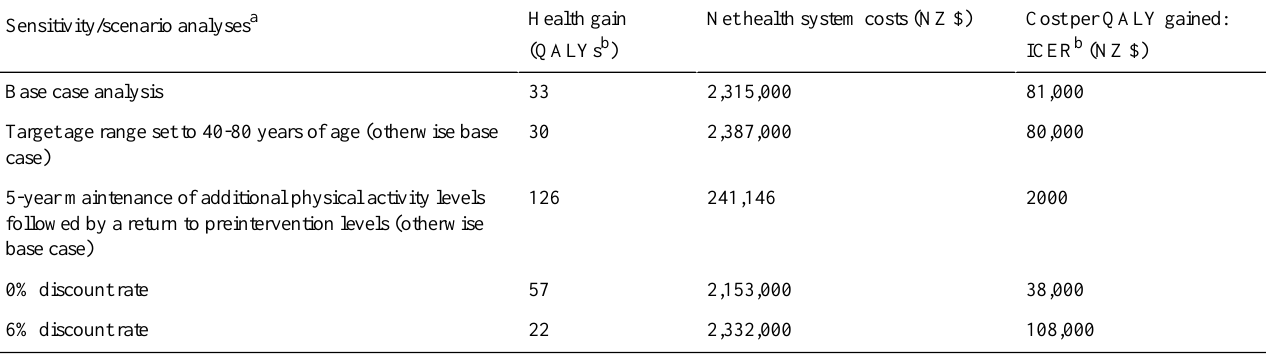
Table 4. Sensitivity and scenario analyses for a one-off national-level mass media campaign to promote smartphone apps for physical activity (expected value analysis, lifetime perspective, 3% discount rate, unless otherwise